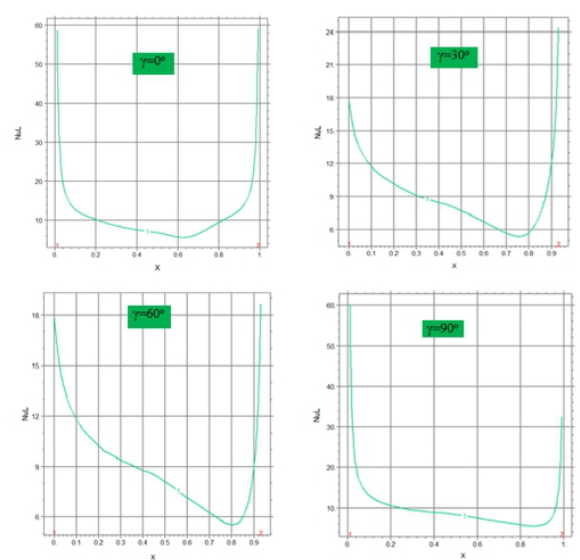
Fig. 9. Local Nu fluctuate along a heated surface; Ra = 10 6 , Ω = 500, and C = 0.2